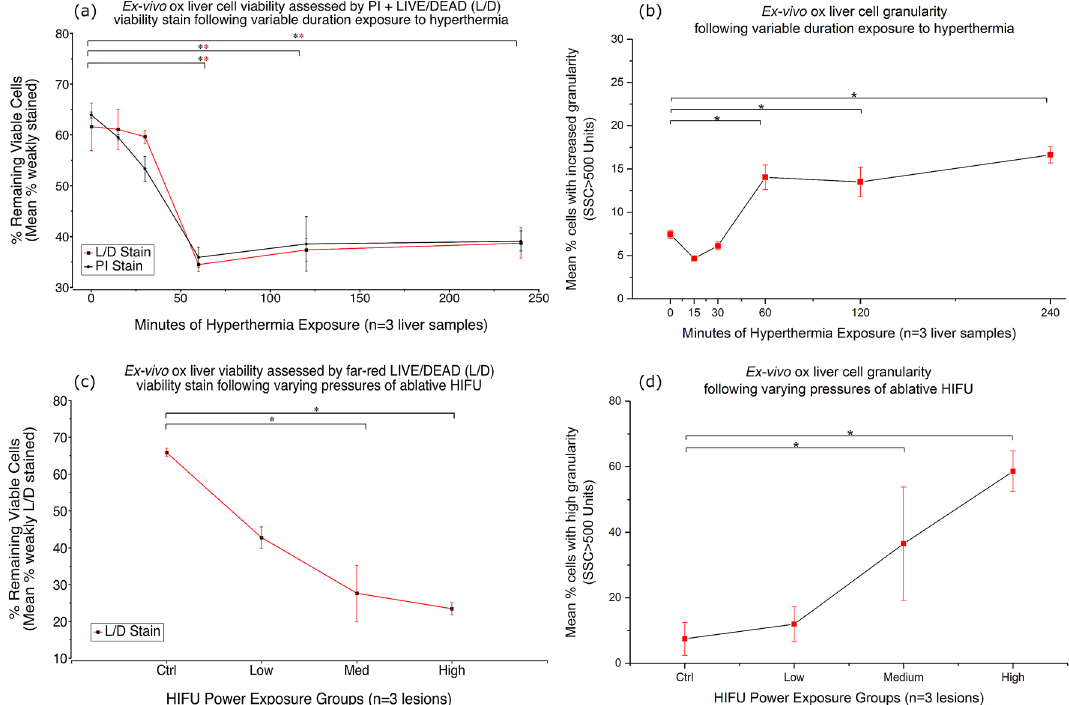
Figure 7. Cell viability analysis for ex vivo bovine liver experiments. ( a ) Mean cell viability plot of cells recovered from control liver and liver exposed to varying durations of hyperthermia (45 °C) assayed at 16 h (N = 3). One-way ANOVA with Fisher’s LSD revealed significant increase in cell death (p < 0.01) for the groups treated with 60, 120 and 240 -min of hyperthermia when compared to the control, 15- and 30-min groups in any combination for both PI and L/D stains (**). ( b ) Cell granularity analysis for the same (hyperthermia) group (N = 3). One-way ANOVA with Fishers LSD revealed a significant increase (p < 0.01) in granularity (SSC) for the 60-to-240-min hyperthermia exposure groups when compared to the control. ( c ) Mean cell viability plot of cells recovered from control liver and HIFU-ablated lesions fixed at 4 h and assayed the following day (N = 3). One-way ANOVA with Fisher’s LSD revealed significant increase in cell death (p < 0.01) in both the medium and high-power groups compared to both the control group in any combination for the L/D stain (*). ( d ) Cell granularity analysis for the same (HIFU) group (N = 3). One-way ANOVA with Fishers LSD revealed a significant increase (p < 0.01) in granularity (SSC) for the medium and high HIFU exposure groups when compared to the